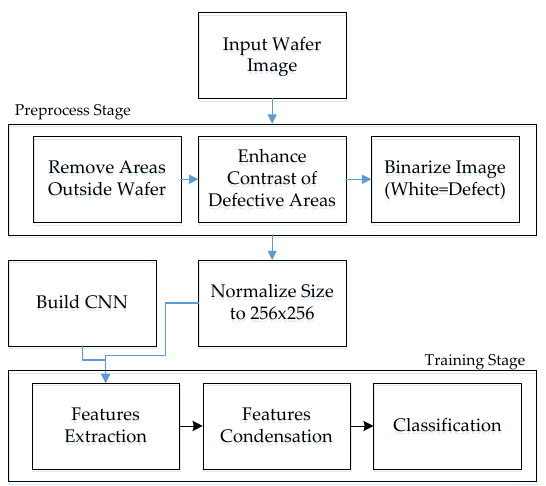
Figure 4. The system flowchart.